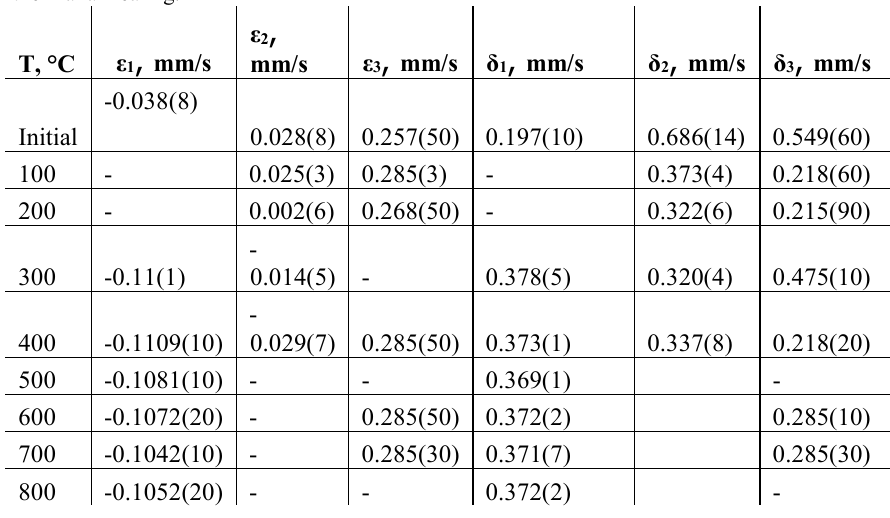
Table 2. Data of changes in the values of the quadrupole displacement and isomer shift as a result of thermal